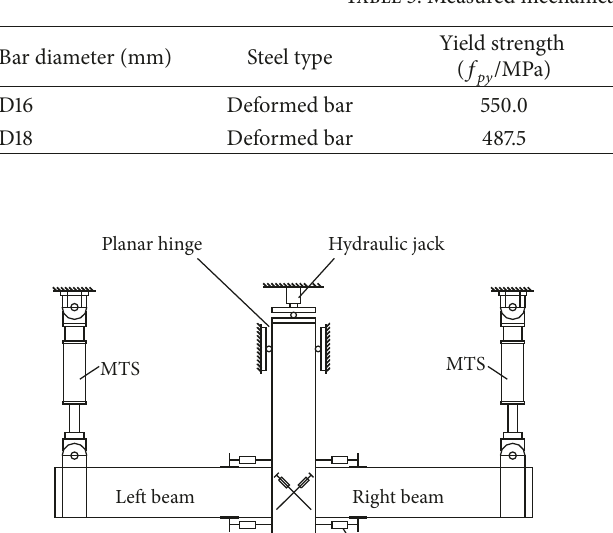
Table 3: Measured mechanical properties of reinforcements.